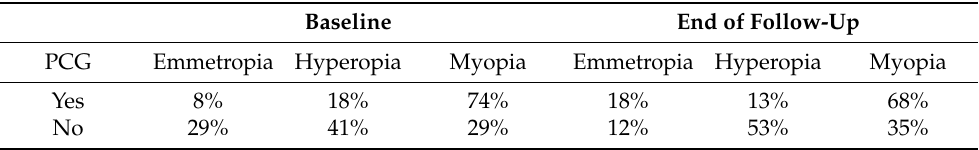
Table 3. Refractive status in eyes with primary childhood glaucoma (PCG) (upper line) and eyes with other forms of childhood glaucoma than PCG (lower line) at the baseline and end of follow-up. Baseline End of Follow-Up PCG Emmetropia Hyperopia Myopia Emmetropia